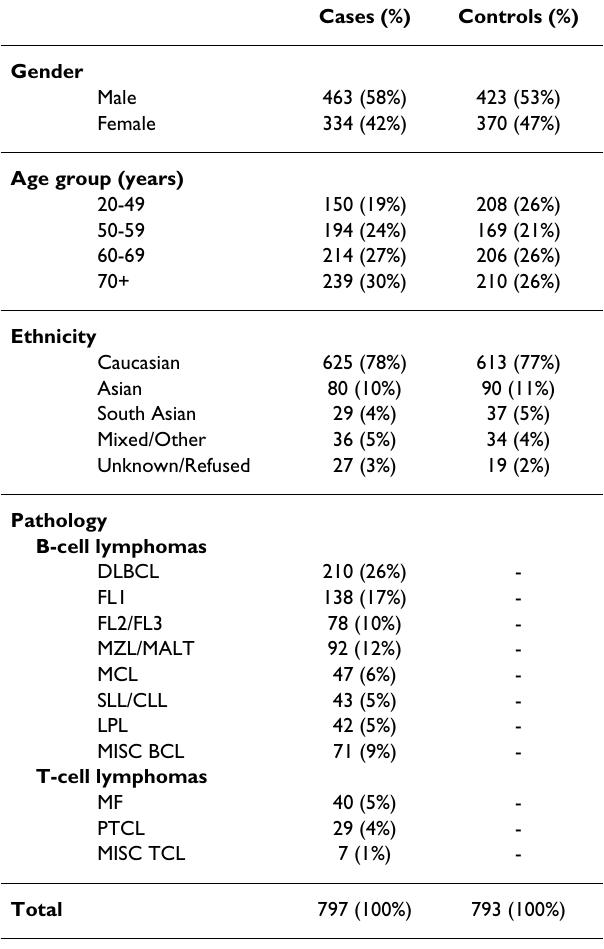
Table 1: Characteristics of the Study Population.